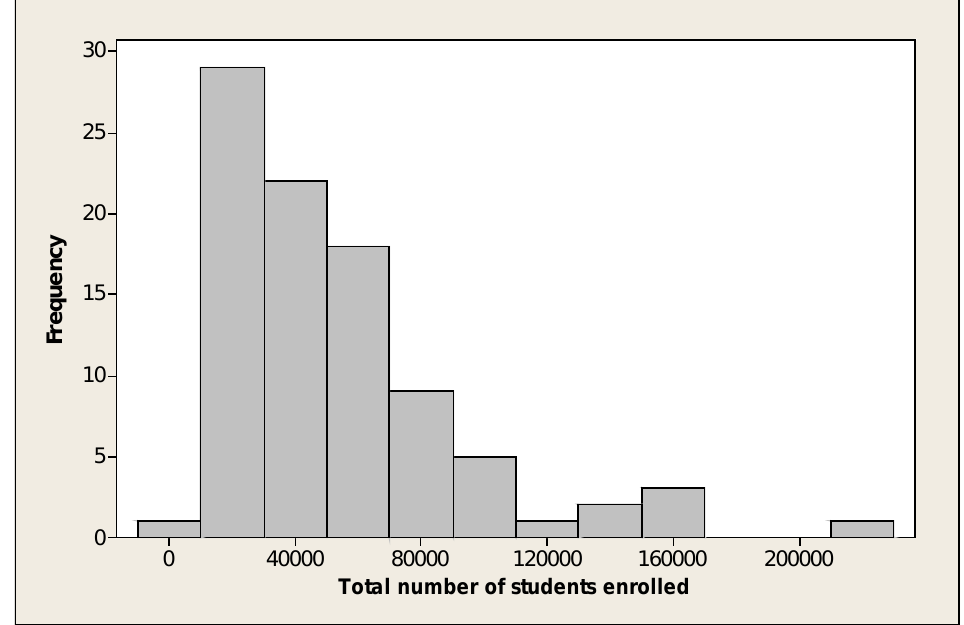
Figure 1 . Histogram of total enrolment numbers for the sampled courses ( n = 91).